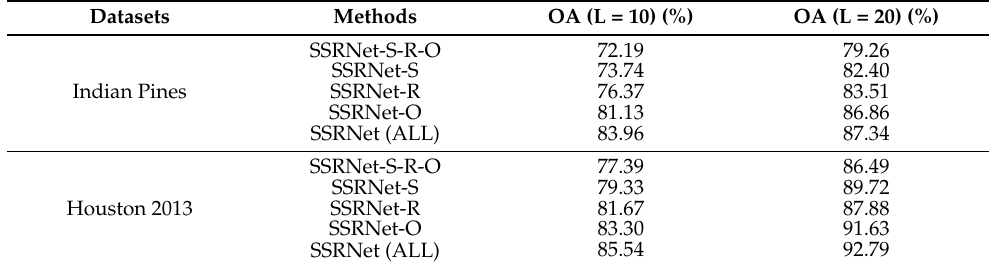
Table 9. Ablation study of the influence of components in our SSRNet on Indian Pines and Hous- ton 2013.